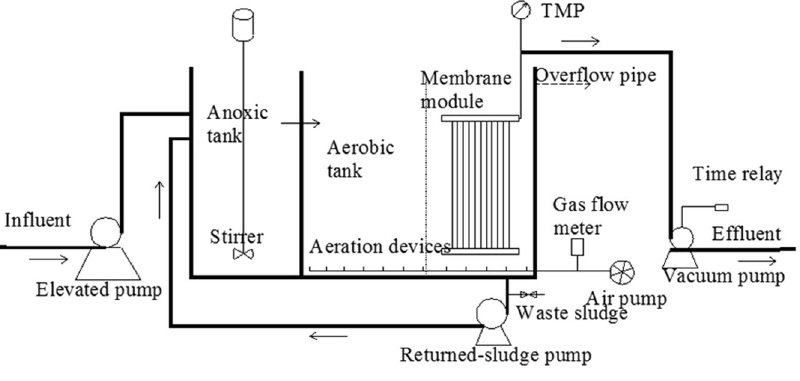
Figure 7. Schematic design of the